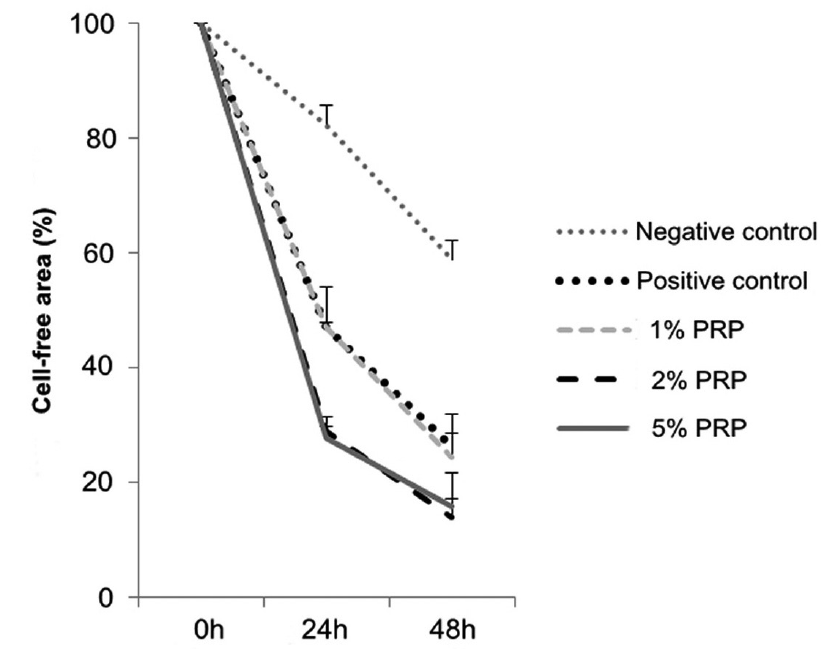
Figure 6- Cell-free area percentage in experimental media at 0, 24 and 48 hours (h)